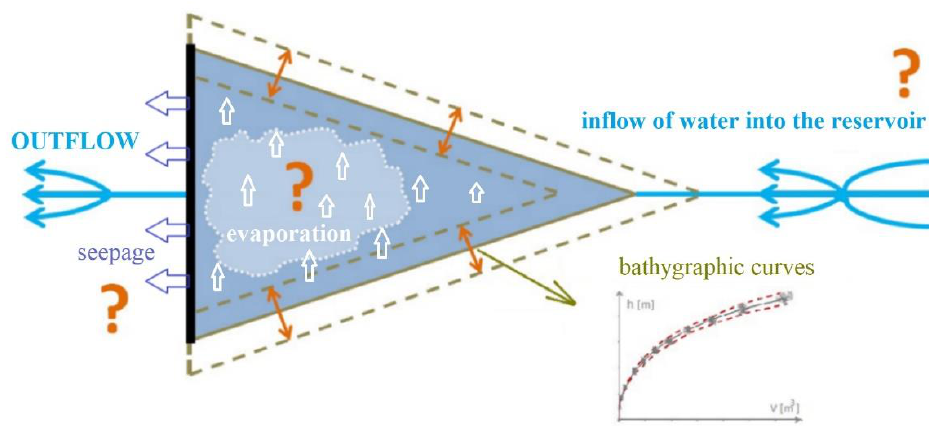
Figure 4. Symbolic depiction of the introduction of considered quantities burdened with uncer- tainties.